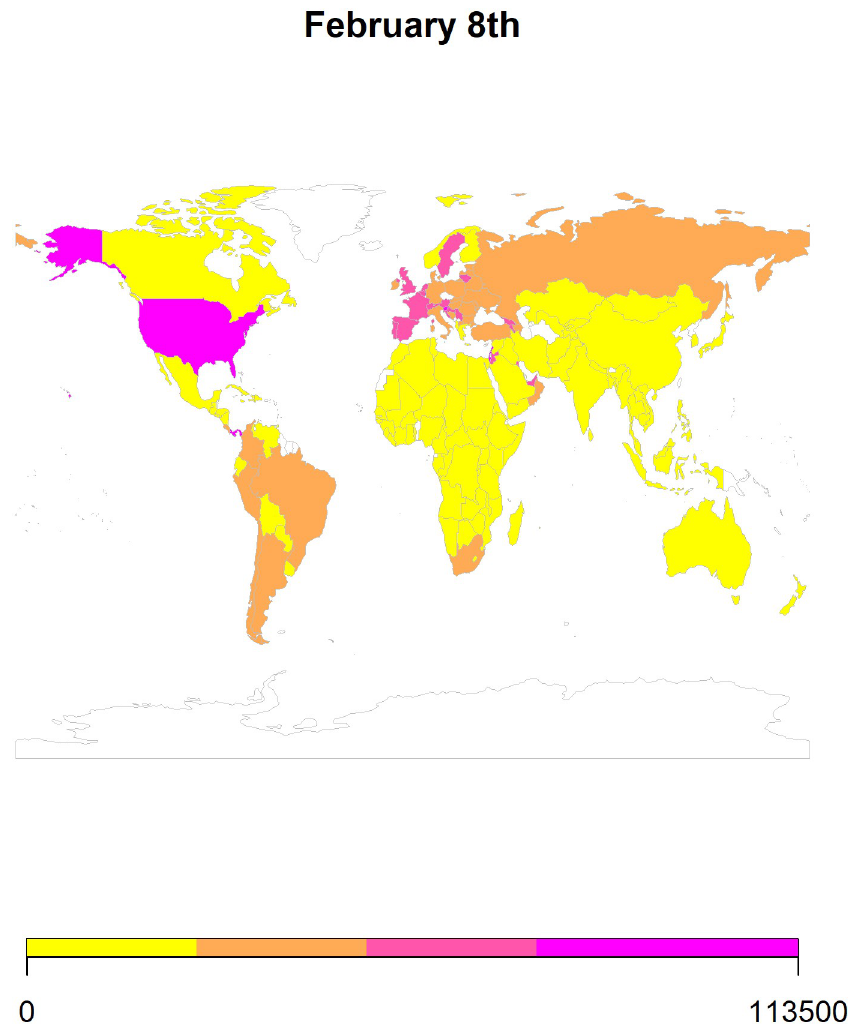
Fig 7. The heat map using the ARIMA forecasts for 8 th February